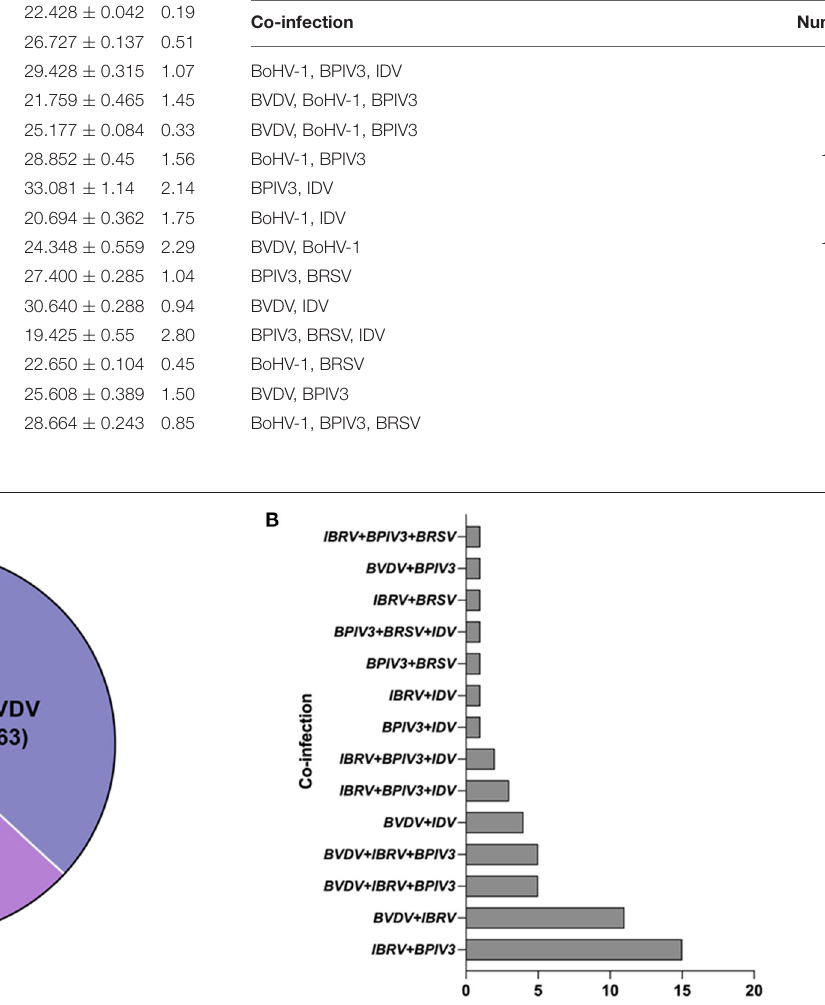
Frontiers in Veterinary Science |